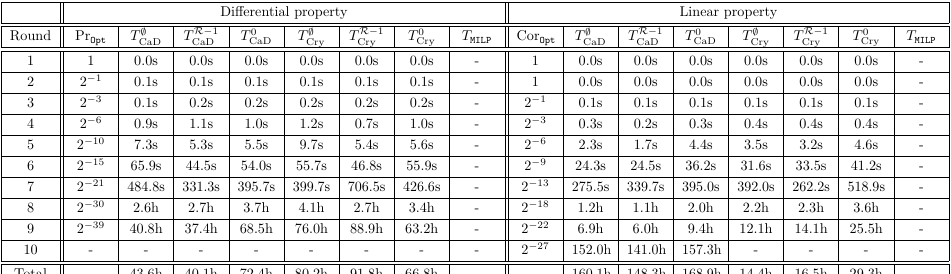
Table 21: Experimental results of SPECK128